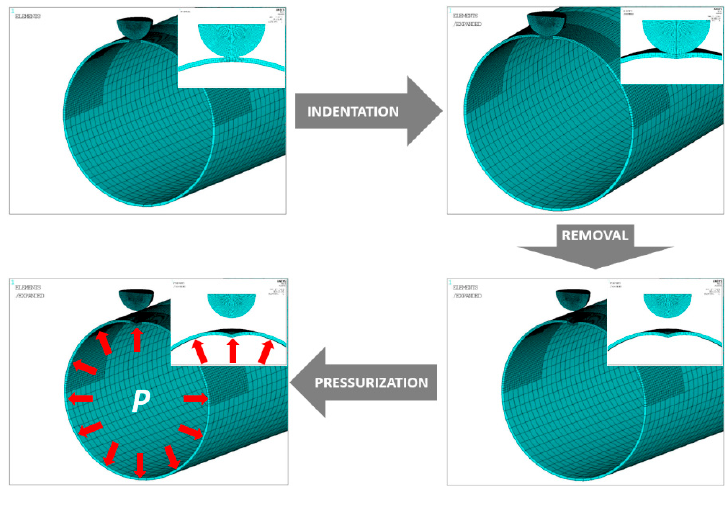
Figure 1. Loading condition of FEA.